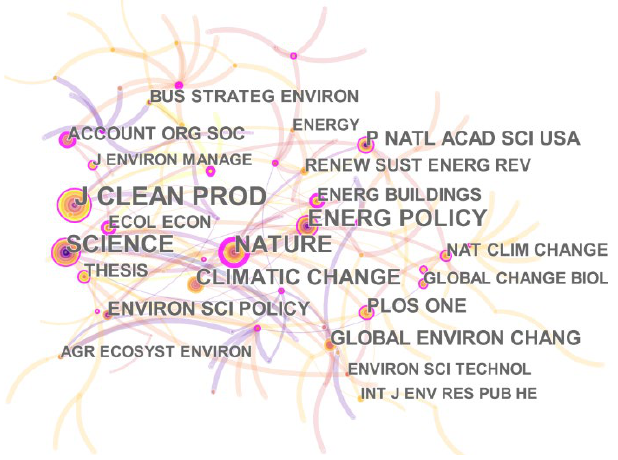
Figure 8. A visualization of the journal co-citation network .